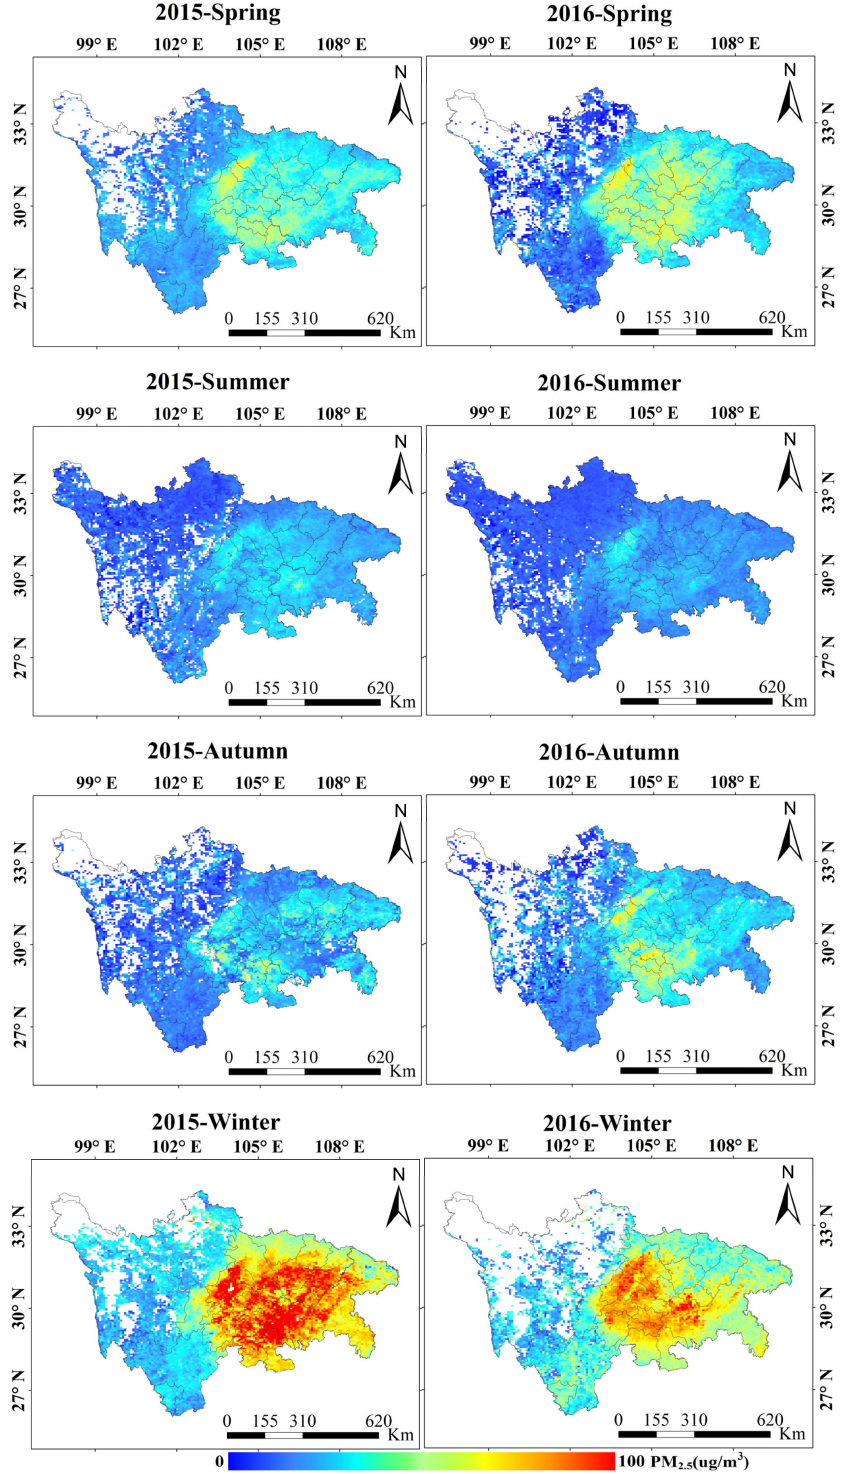
Figure 7. Spatiotemporal distributions of PM 2.5 concentrations in Sichuan–Chongqing